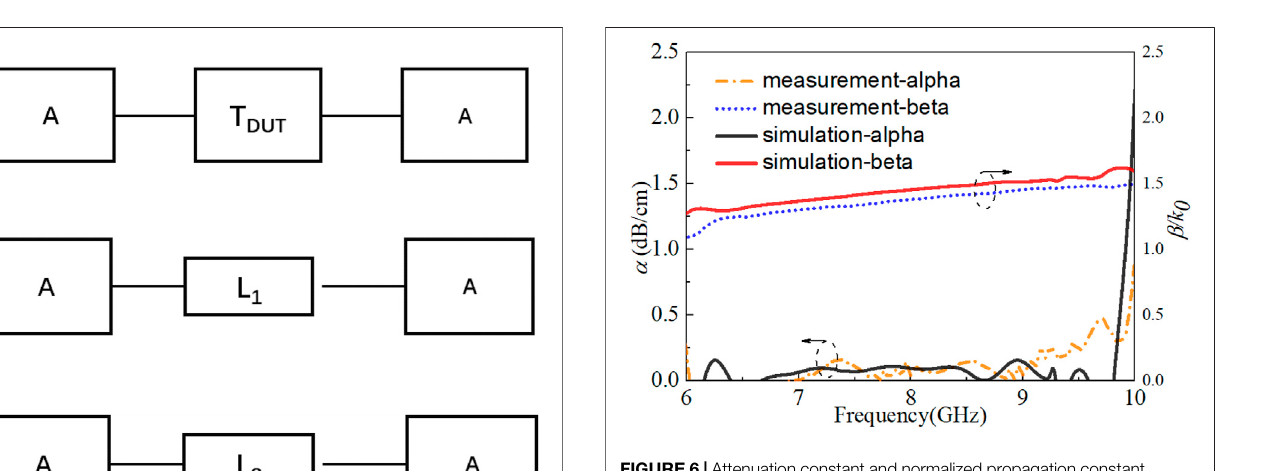
FIGURE 6 | Attenuation constant and normalized propagation constant calculated by the simulation and measurement results. k 0 is the propagation constant in the free